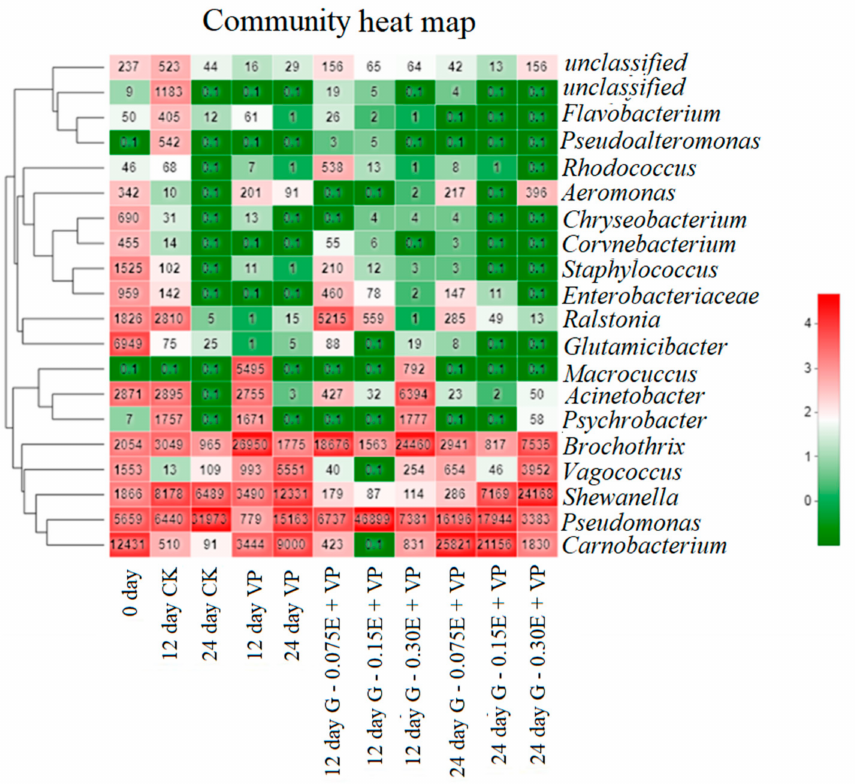
Figure 4. Relative abundance of microbiota at the genus level. Rows in the heat map represent different genus-level phylotypes, while columns represent different common carp samples. The color intensity is proportional to the abundance of OTUs in each